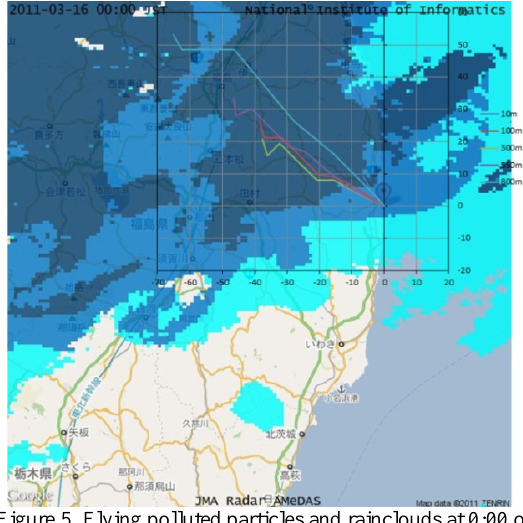
Figure 5. Flying polluted particles and rainclouds at 0:00 on March